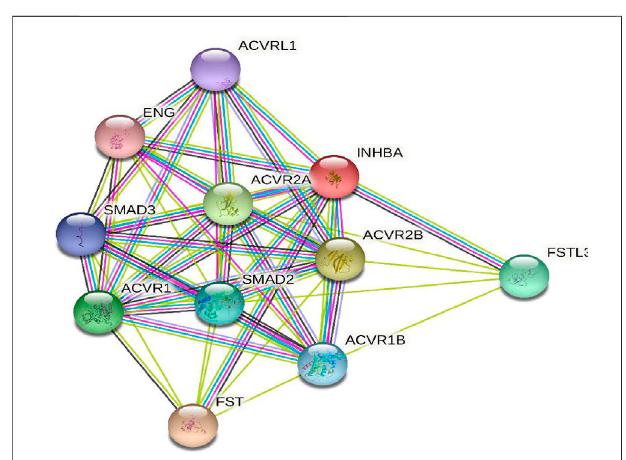
FIGURE 2 | Top 10 INHBA -binding proteins obtained by STRING